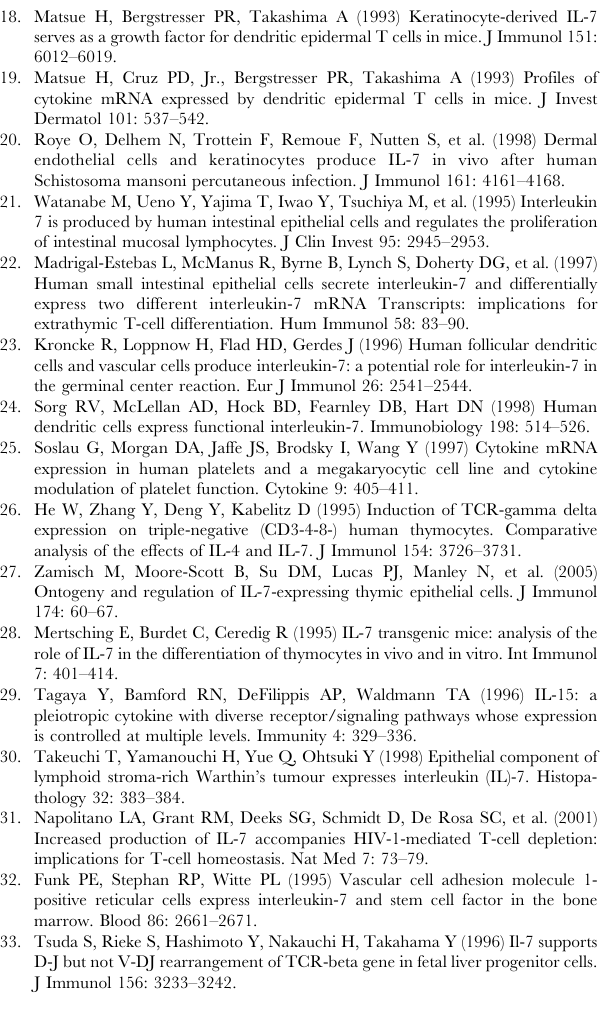
Movie S2 Central memory cells (TCMs) were obtained by in vitro differentiation of T cells from OT-1xRAG 2 / 2 mice. TCMs were labeled with CFSE and injected intravenously twice ( 2 24 hr and 2 2 hr) into IL7promECFP mice. Bone marrow was visualized by intravital microscopy. CFSE labeled TCMs (green) exit the blood stream (red) and some interactions with ECFP producing cells (blue) were observed. The video spans a 40 minute